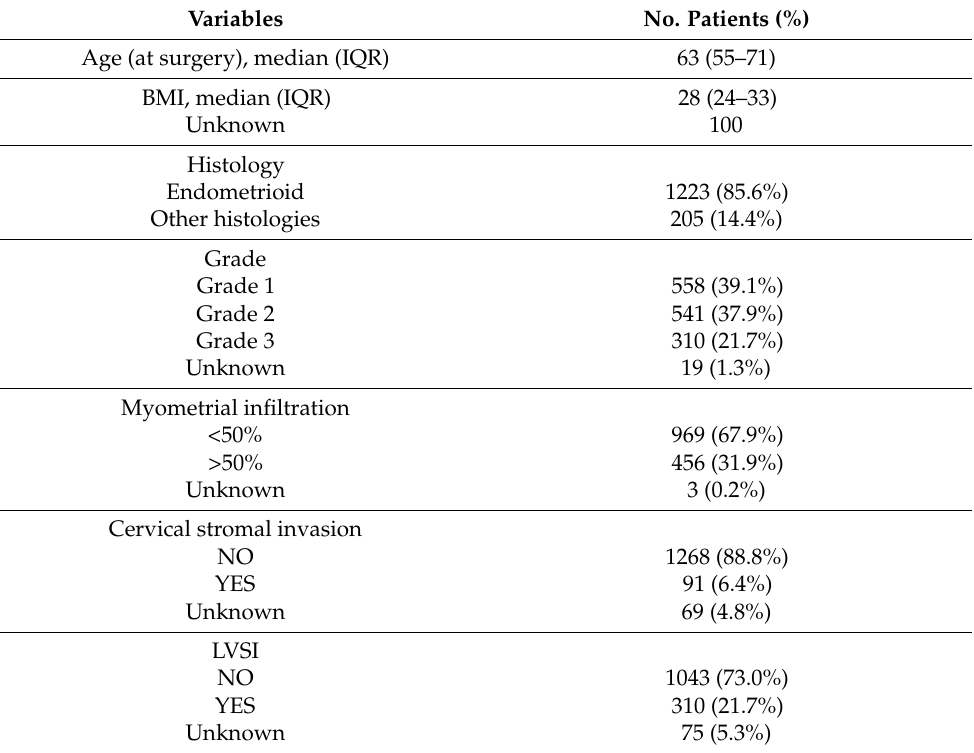
Table 1. General characteristics of the study population (N =